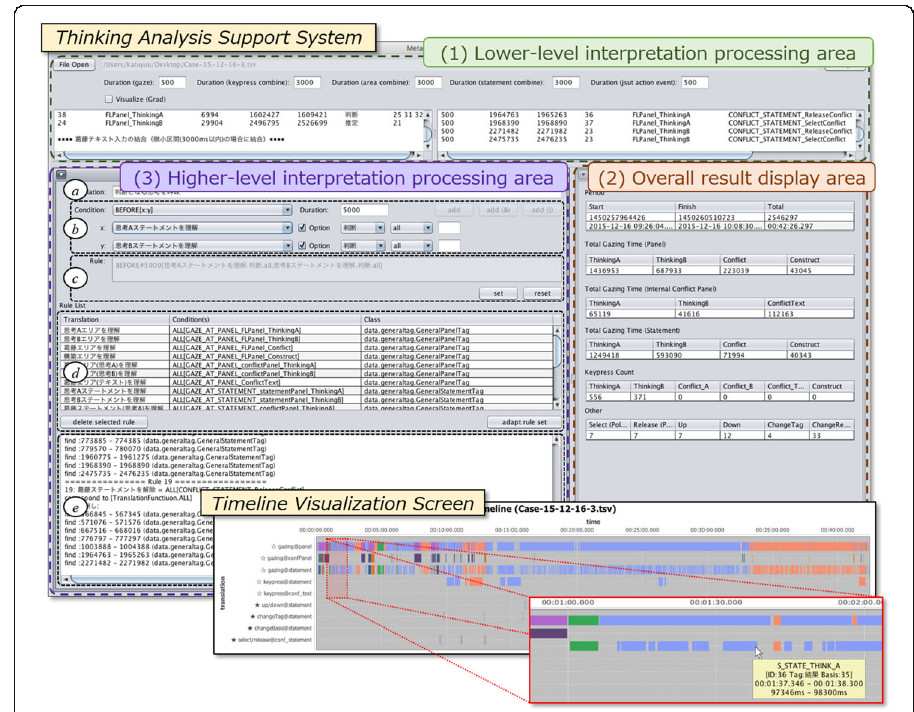
Fig. 6 Thinking analysis support system